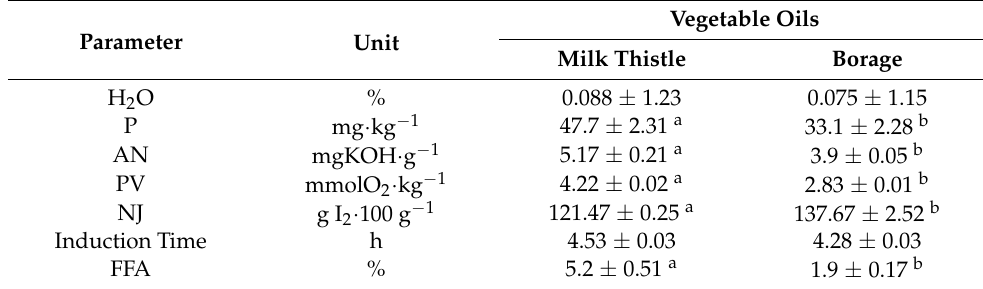
Table 3. Primary physicochemical parameters in industrial